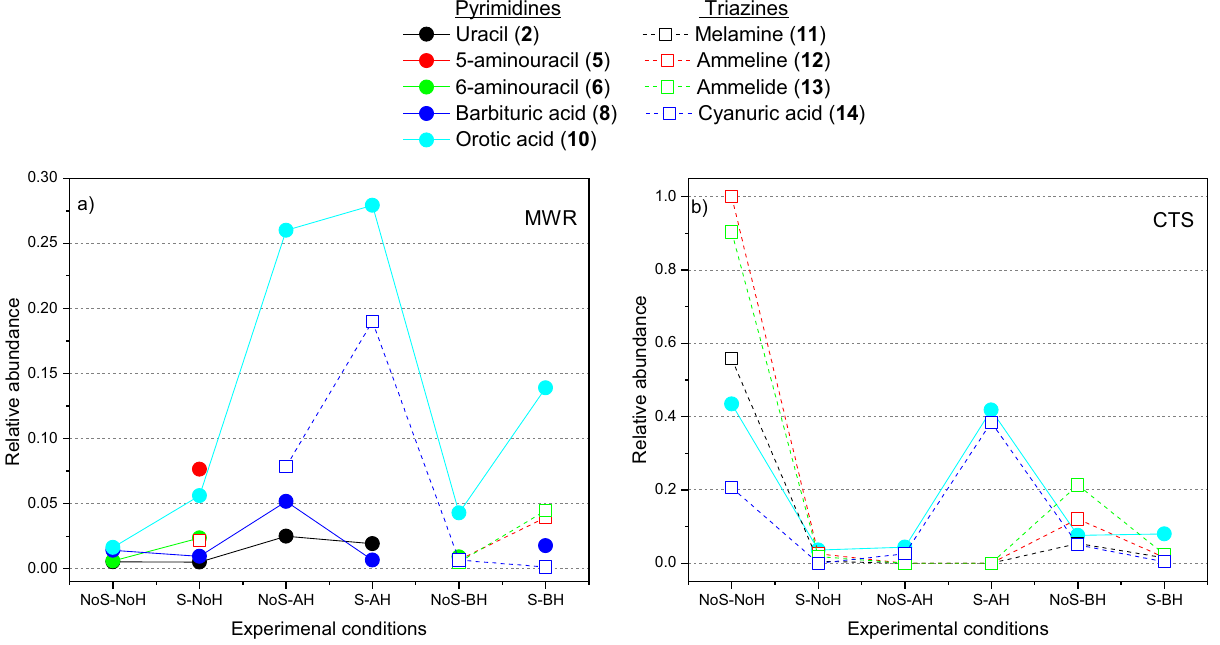
Figure 6. Results of the semiquantitative GC–MS analysis for pyrimidines and triazines from the cyanide polymerizations under plausible alkaline hydrothermal conditions, simulating ( a ) subaerial environments (MWR, 180 °C) and ( b ) aerial environments (CTS, 80 °C). For each analyte, the contributions from the gel and sol fraction chromatographic peaks are considered. The abscissa axis indicates the experimental conditions used in each case: NoS = static experiments without stirring; S = stirring experiments. NoH = nonhydrolysed samples; AH = acid hydrolysed samples; BH = basic hydrolysed samples. The value 1 corresponds to the addition of the area of the chromatographic peak from the gel fraction plus the area of the chromatographic peak from the sol fraction of the ammeline ( 12 ) from the conventional heating polymerization of cyanide in a no stirring experiment (CTS, NoS-NoH). All areas were normalized, taking into account the amount of mg used for each TMS-derivatized